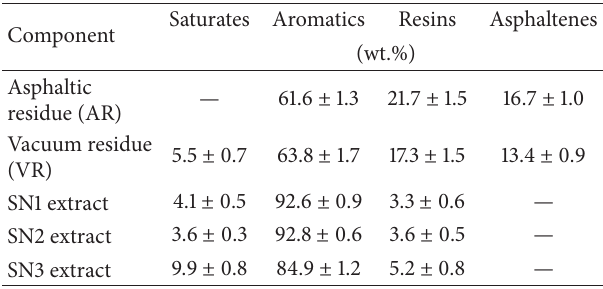
Table 2: SARA analysis of the individual components of bitumen blends.